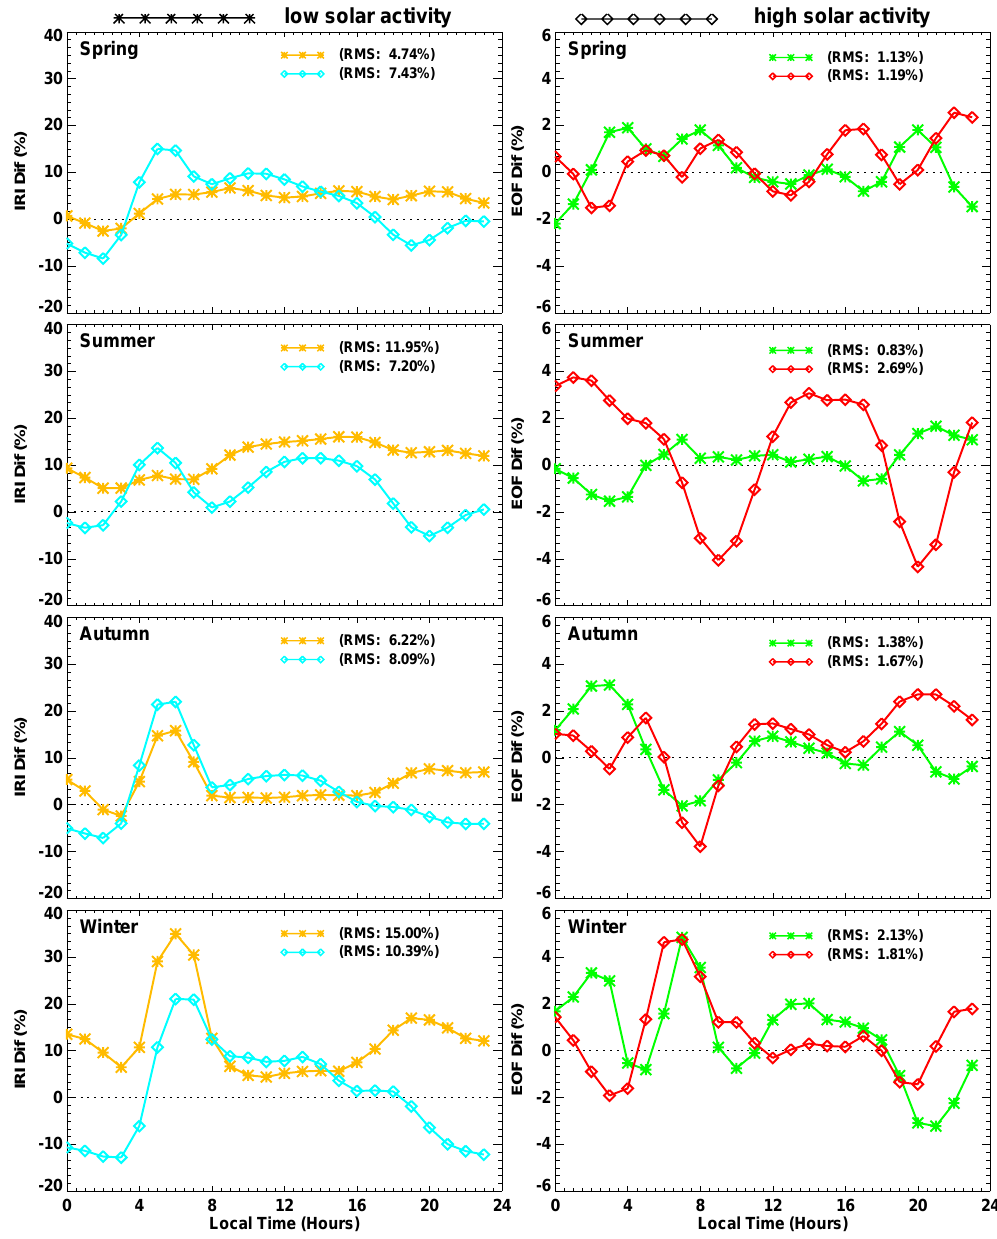
Fig. 9. Diurnal variation of relative errors and relative mean square errors between model and the observational data.